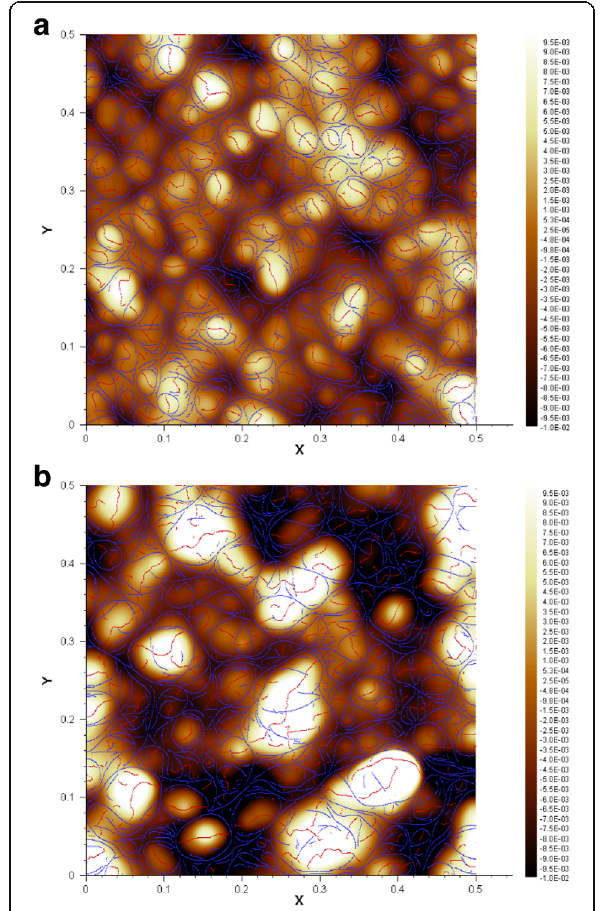
Fig. 7 Enhanced AFM 2-D height images by curvature-dependent